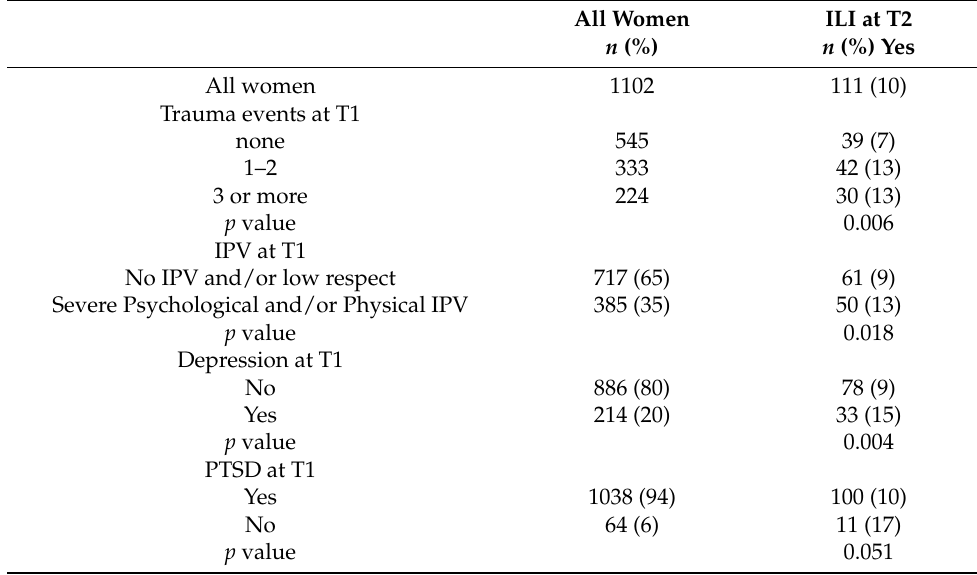
Table 2. Influenza-Like Illness in pregnancy in relation to trauma, IPV, depression and PTSD.